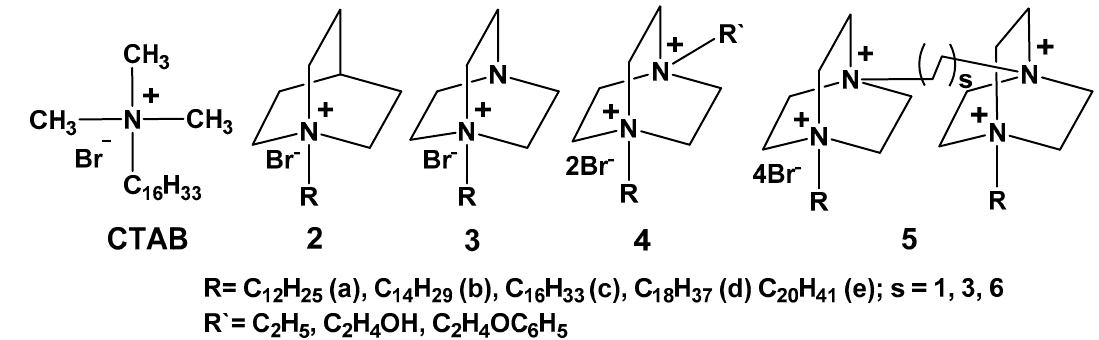
Figure 2. Structural formulas of quaternized derivatives of quinuclidine ( 1a–d ) and monocationic (1,4-diazobicyclo[2.2.2]octane (DABCO)-n) ( 3a–d ), dicationic (Et-DABCO-n) (4-Et a–d), (C 2 H 4 OH-DABCO-n) (4-C 2 H 4 OH a–d ), (4-C 2 H 4 OC 6 H 5 a–d ), and tetracationic gemini n-DABCO-2-Dabco-n ( 5a–d ) surfactants.